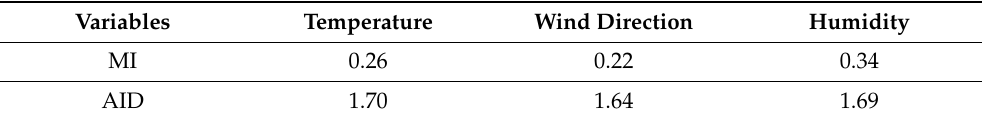
Table 4. Comparison of MI value and AID value between PM2.5 in the GY area and temperature, wind direction, and humidity in the Haidian